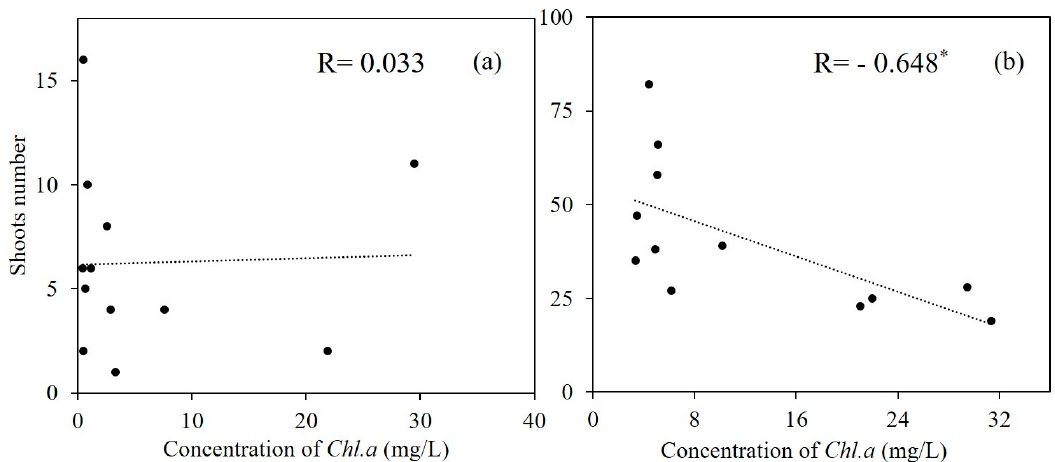
Figure 3. Correlation between concentrations of Chl. a and number of emerged seedlings in